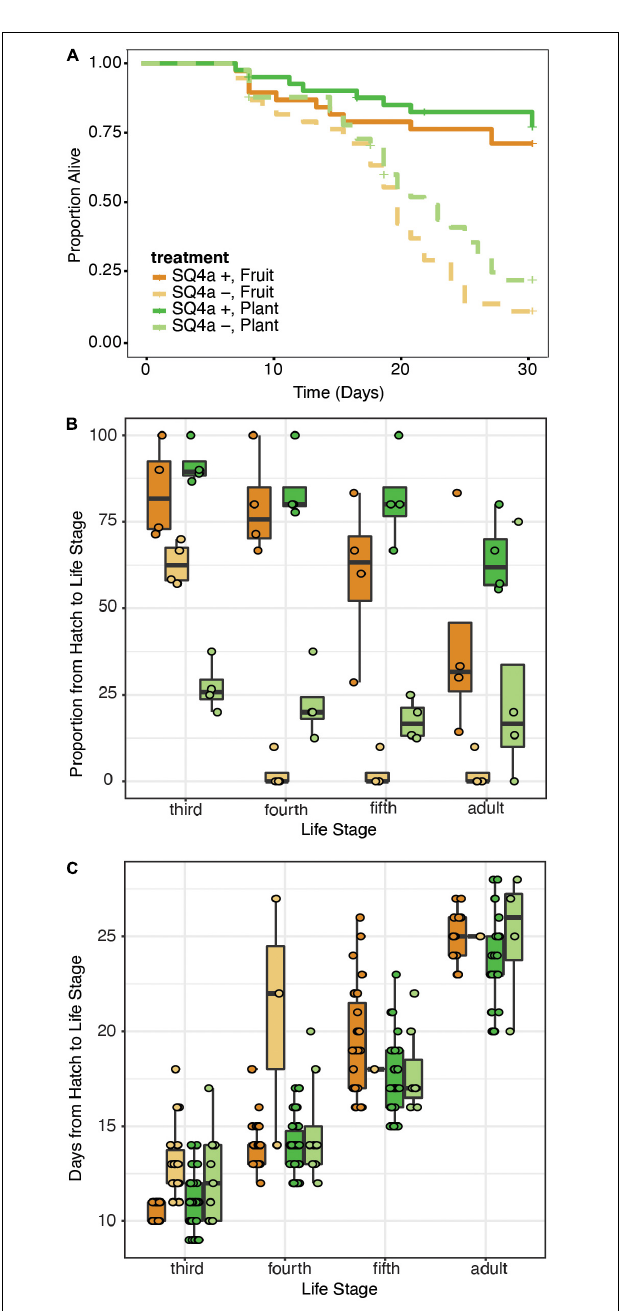
FIGURE 7 | Caballeronia sp. SQ4a association provides similar survival and developmental benefits when squash bugs are reared on plants or fruits. (A) Kaplan-Meier survival curves for Caballeronia -inoculated (solid) and -uninoculated (dashed) treatments when bugs were reared on squash plants (green) and fruits (orange) ( n = 41 individuals for each plant treatment, and n = 38 for each fruit treatment). Data is censored after 29 days, at the time individuals reached adulthood or, in a few cases, when individuals escaped from cages (indicated by crosses). (B) Proportion of individuals in each cage surviving from hatch to each subsequent life stage over the course of the 29 day experiment (color scheme as in panel A ). Proportions for each cage are overlaid on box-whisker plots. (C) Development time from hatch to each instar (color scheme as in panel A ). Points, overlaid on box-whisker plots, indicate estimated development time for each individual that made it to that life